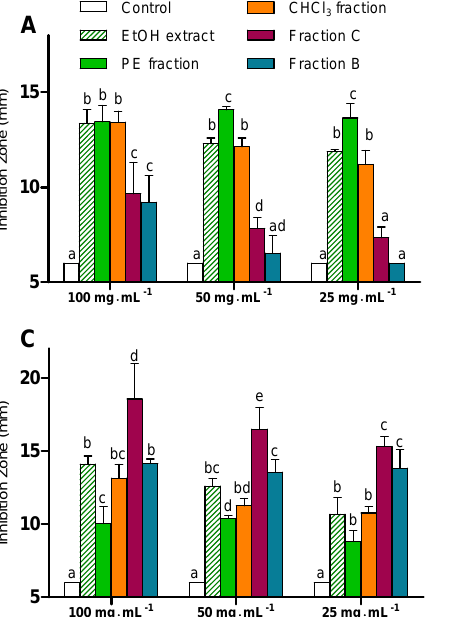
Figure 1. Antibacterial activities of the EtOH extract as well as PE, CHCl fractions. Data are means ± SD, n = 3. Within each concentration treatment, columns containing the same letter are not significantly different according to Duncan’s new multiple range test at P <0.05. [(A) E. coli , (B) B. subtilis , (C) M. tetragenus , (D) P. fluorescens